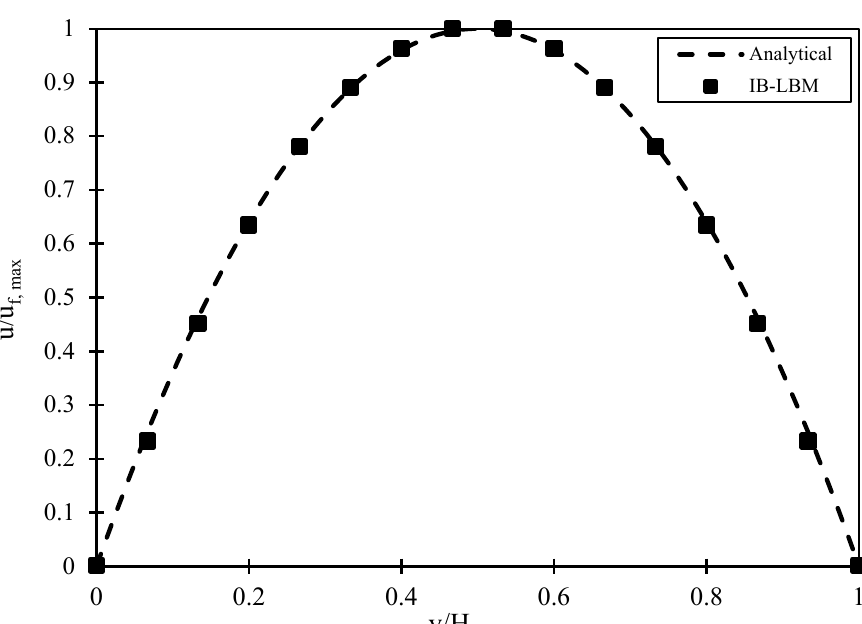
Figure 3. Velocity profile (normalized) of Poiseuille flow in the microchannel and its comparison with the Hagen–Poiseuille analytical solution.